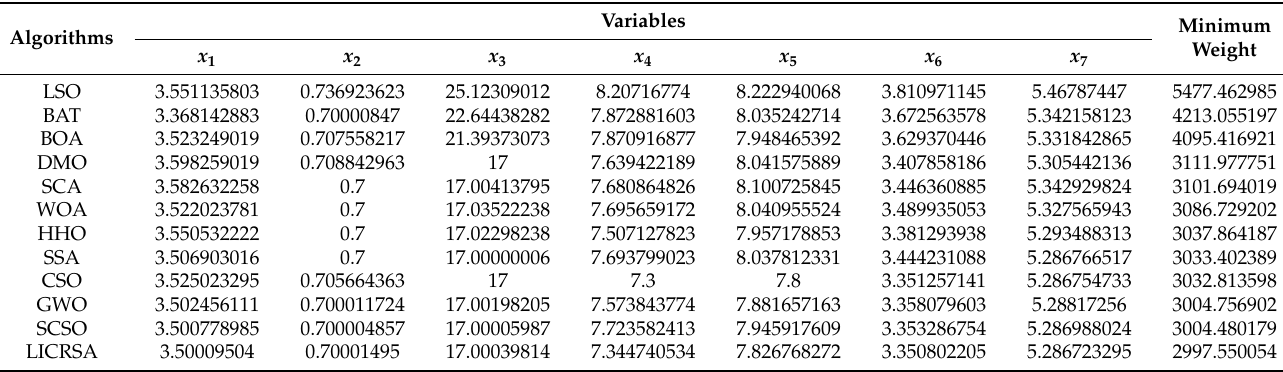
Table 19. Numerical results for the speed reducer design.